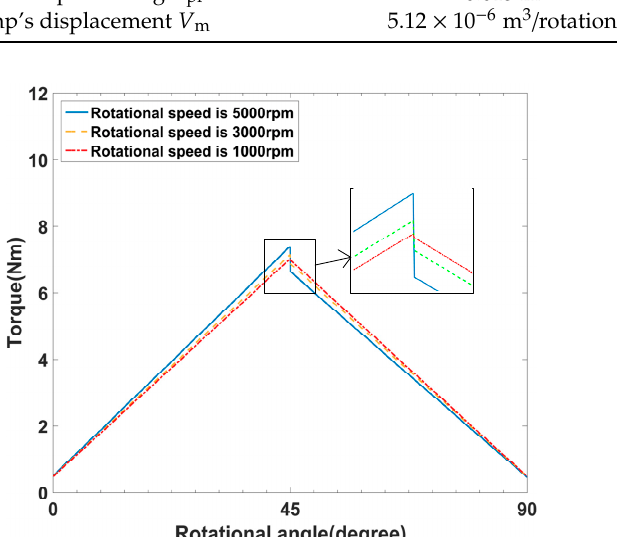
Figure 11. The input torques of the driving set at different rotational speeds and at a load pressure of 8 MPa.